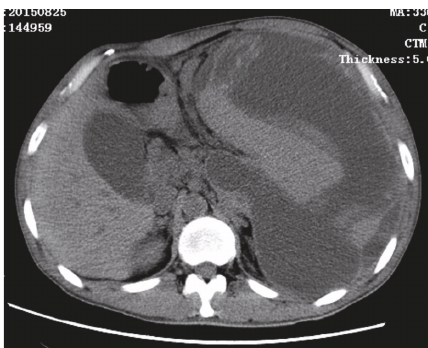
Figure 2: CT scan showing a large subcapsular splenic hematoma with a large pancreatic pseudocyst.